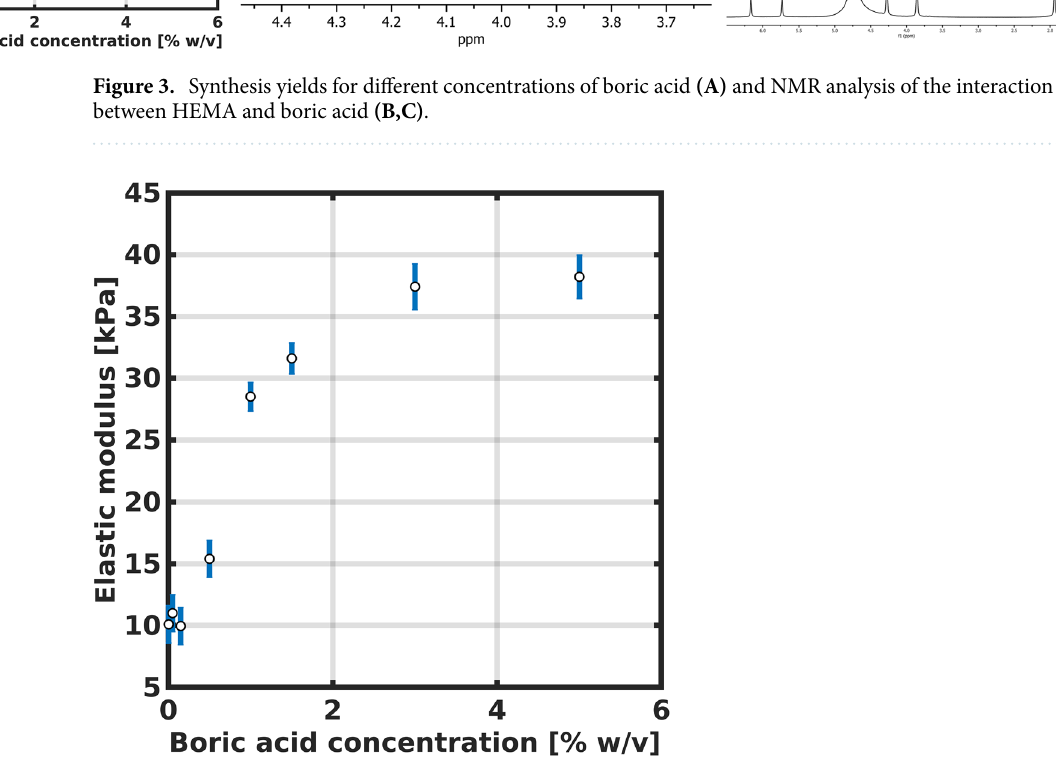
Figure 4. Elastic modulus for the synthesized poly(HEMA)